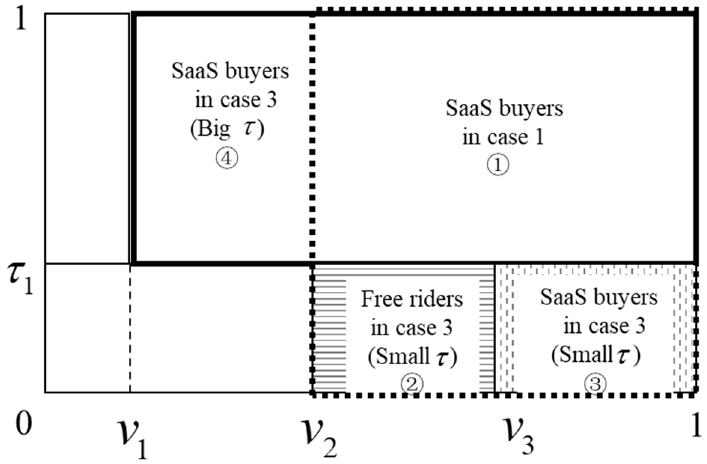
Figure 1. The distribution of users under the single SaaS product strategy.